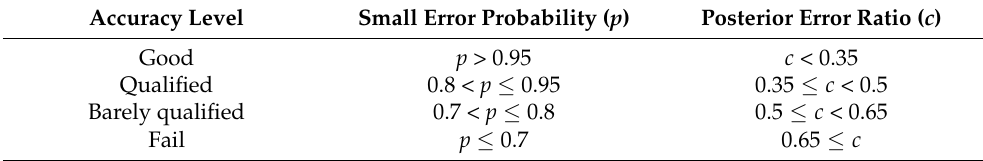
Table 2. Judgment standard of prediction accuracy for the GM(1,1)